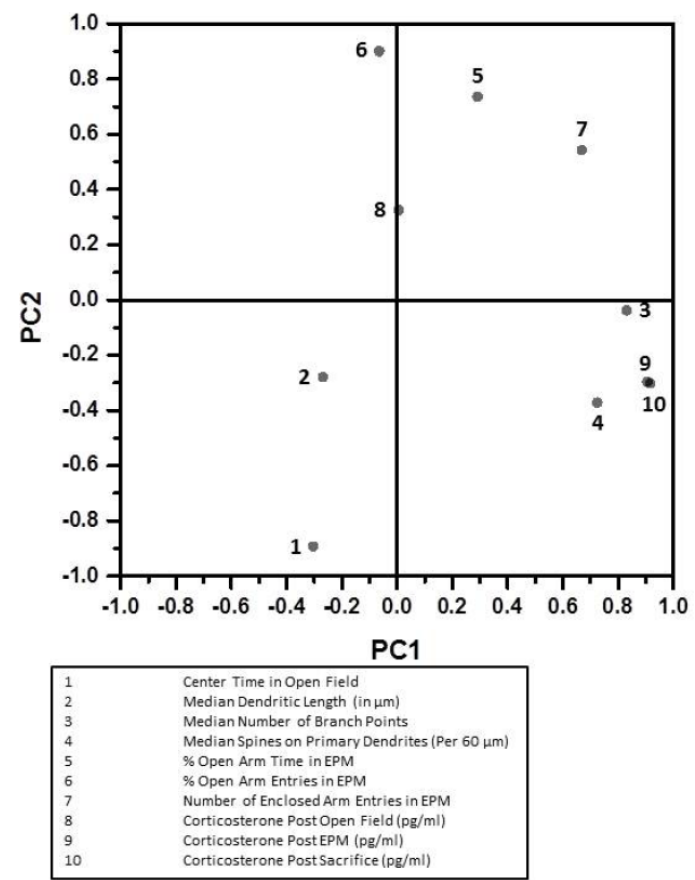
Figure 6. Principal component analysis of the measured endpoints. Initial two dimensions are depicted along abscissa and ordinate. Numerals adjacent to dots represent the endpoints, listed in the inset underneath.